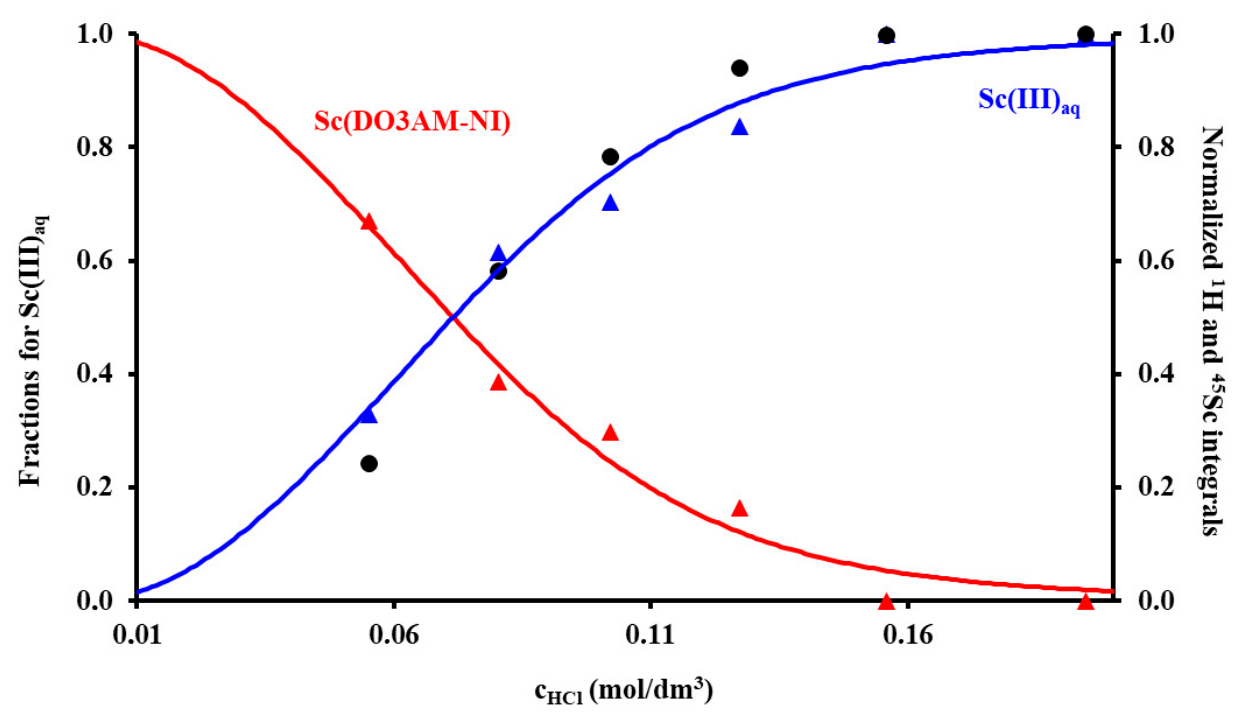
Figure 2. The species distribution of the Sc(III)–DO3AM-NI–H + system (solid lines) calculated from the equilibrium data obtained by 1 H and 45 Sc-NMR spectroscopy co-plotted with the normalized intensity of the Sc(III) aq (black dots) and those corresponding to the nitroimidazoyl protons in bound (red triangles) and free (blue triangles) ligand present in solution (3.32 mM ligand and ScCl 3 , I = 0.15 M NaCl, 37 °C).